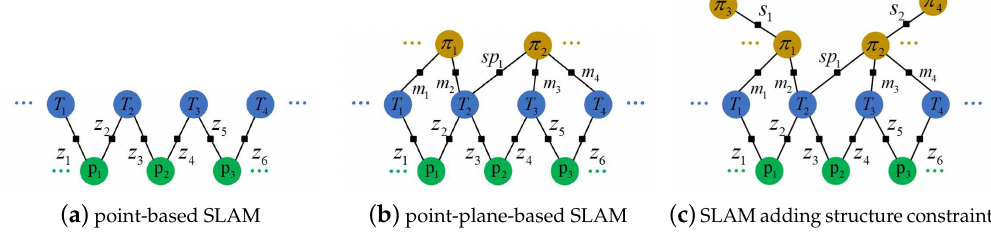
Figure 3. Factor graphs for SLAM. Circles denote vertices and black squares denote factors. ( a ) A simple point-based SLAM. The blue circles denote the keyframe poses and the green circles are point landmarks. ( b ) A point-plane-based SLAM. Yellow circles denote the plane landmarks. sp means supposed planes in the frame. ( c ) A point-plane-based SLAM adding structural constraints. More planes are included in the local map to add parallel or perpendicular